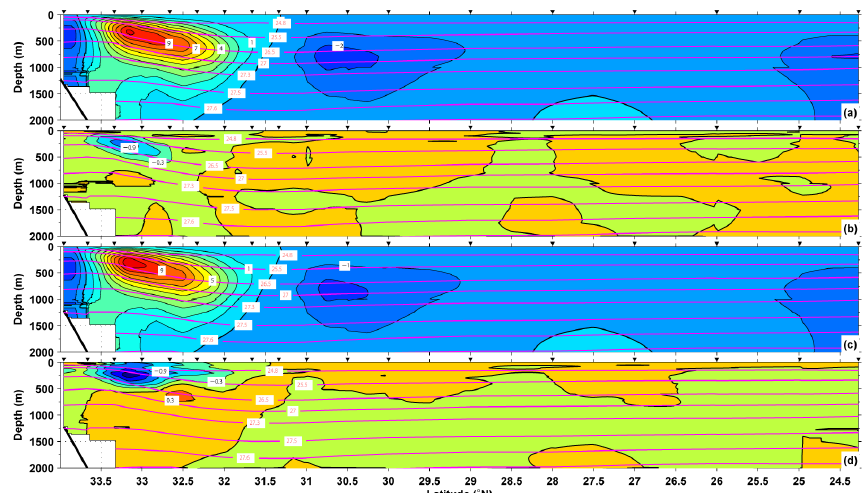
Fig. 6. Nitrate flux (molm − 2 s − 1 ) for section 137E calculated using the temporally averaged speed from 2000 to 2009, (a) temporally averaged nitrate concentration before 2000, and (c) temporally averaged nitrate concentration from 2000 to 2009. (b) Difference between Fig. 4e and (a) ; (d) difference between Fig. 4e and (c) . Colored areas and black contour lines indicate the nitrate flux with an interval of 1molm − 2 s − 1 in (a) and (c) , and with an interval of 0.3molm − 2 s − 1 in (b) and (d) . Positive values indicate an eastward flux. Red contour lines indicate the eight isopycnal layers. Thick black lines indicate zero nitrate flux. The inverse triangles are the same as those in Fig.